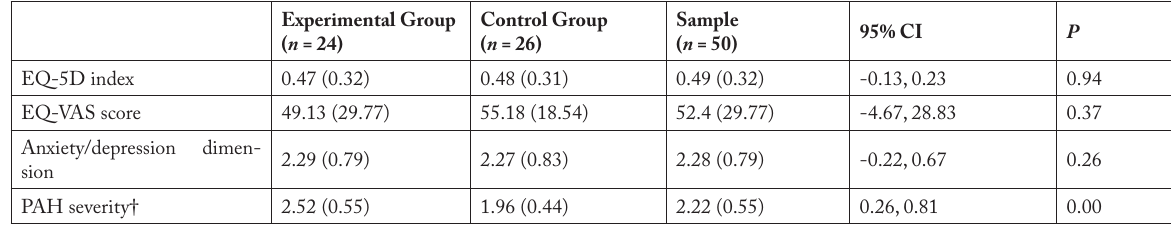
Table 1. Mean and Student t-test for EQ-5D index, anxiety/depression dimension and PAH severity.*